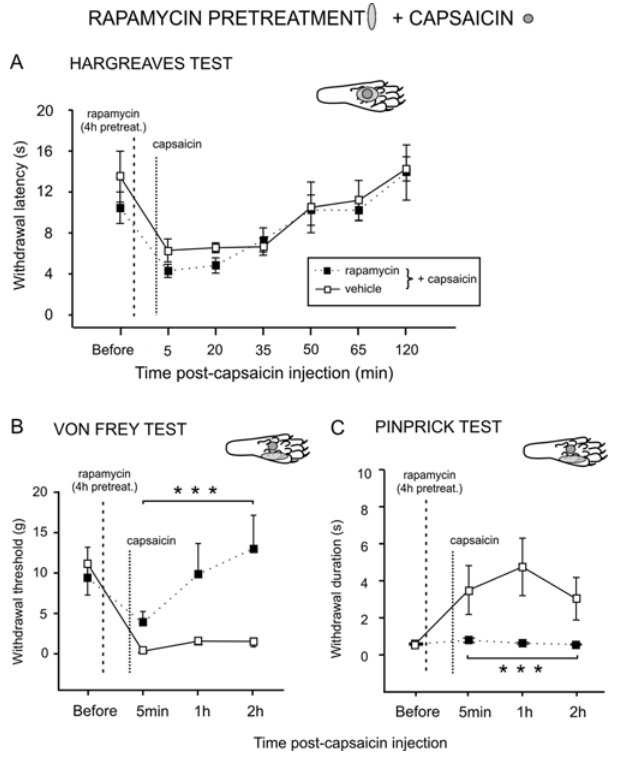
Figure 6. Rapamycin blocks capsaicin-induced secondary mechanical hyperalgesia but not primary hyperalgesia. A , Effect of rapamycin or vehicle on withdrawal latency to heat after capsaicin. Rapamycin or vehicle were injected intraplantar 4 h before capsaicin administration. All injections were made in the center of the plantar surface of the paw. B , C , Secondary mechanical hyperalgesia in the lateral plantar hindpaw was generated by injecting capsaicin into the central plantar surface of the hindpaw. Rapamycin or vehicle pre- treatment was delivered intraplantar in the lateral part of the surface of the hindpaw 4 h before capsaicin injections (see inset diagrams). B , Effect of lateral intraplantar injection of rapamycin or vehicle on mechanical withdrawal threshold on central plantar injection of capsaicin using Von Frey hairs. C , Effect of rapamycin or vehicle on withdrawal response duration to pinprick stimulation after capsaicin. Mean 6 SEM for the injected (left) hindpaw is illustrated in each panel. M, medial; L, lateral. *** P ,